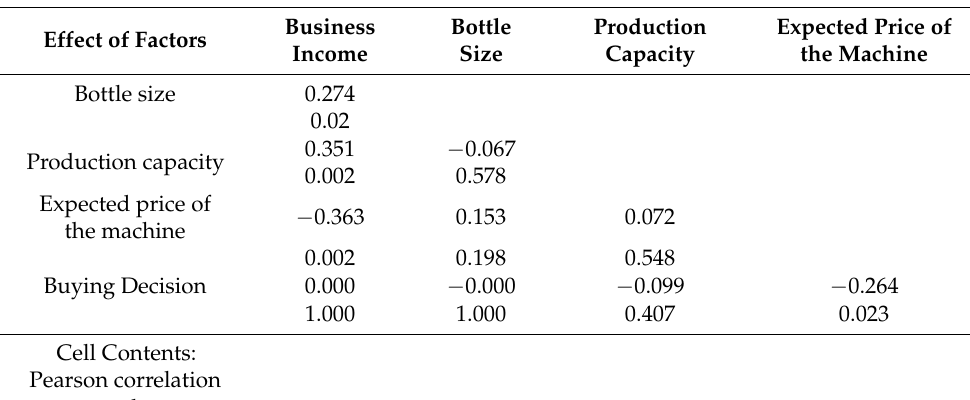
Table 3. Pearson correlation factor.